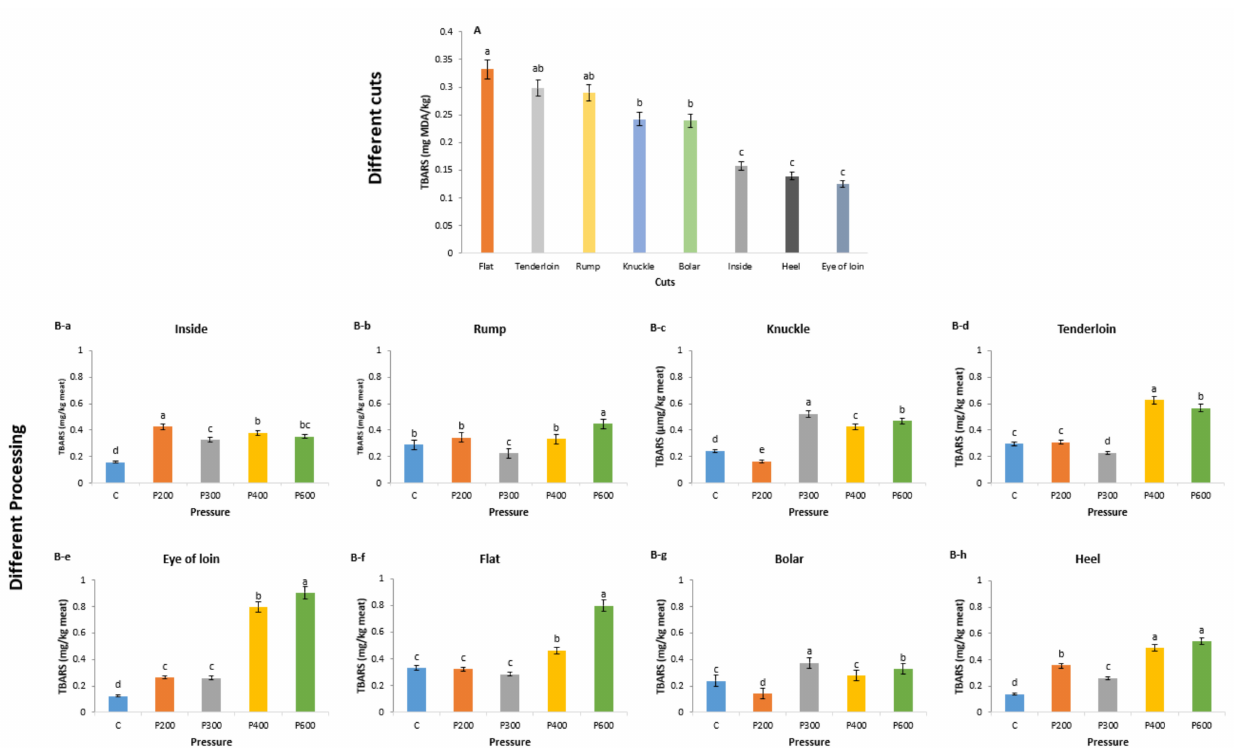
Figure 1. Lipid oxidation marker (thiobarbituric acid reactive substances (TBARS) in di ff erent lamb cuts and high-pressure processing samples. ( A ) di ff erent cuts and ( B ) di ff erent processing means of TBARS value with di ff erent cut samples ( B-a – B-h ) di ff er significantly using Fisher’s least significant di ff erence ( p <